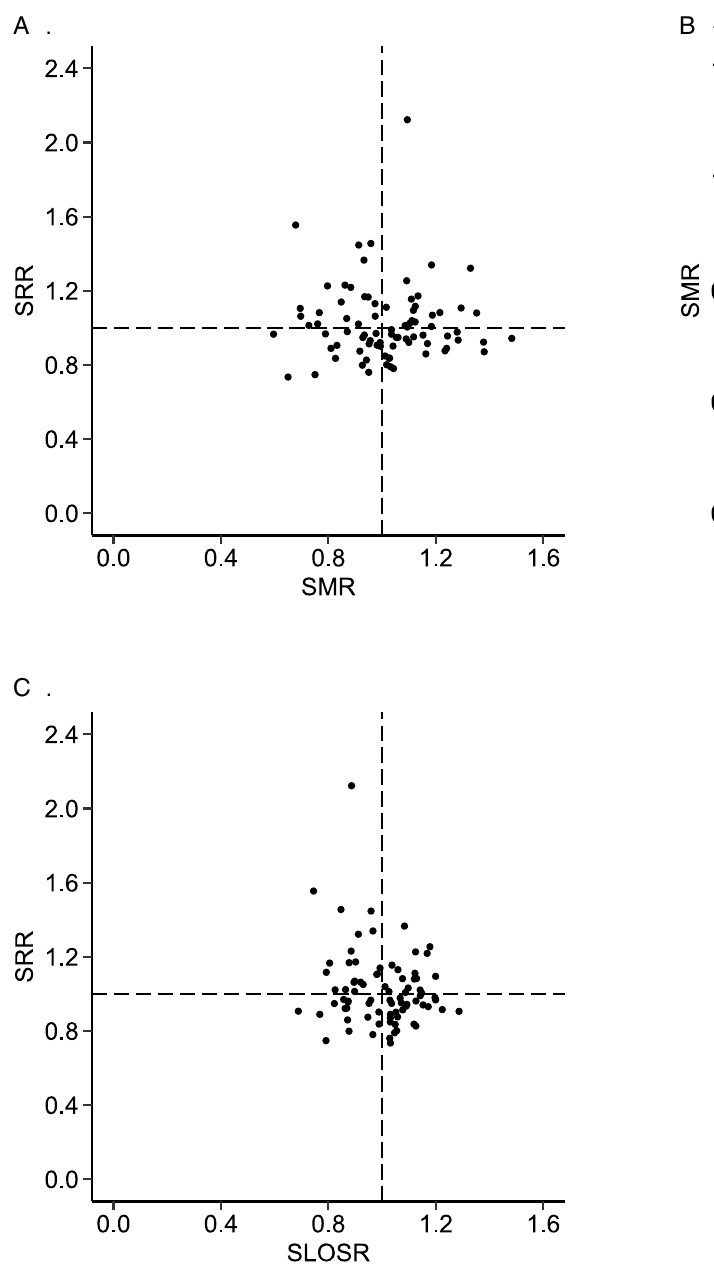
Fig 2. Pairs of quality indicators plotted against each other on ICU level. Fig 2A: standardized in-hospital mortality ratio (SMR) against standardized ICU readmission within 48 hours ratio (SRR). Fig 2B: standardized length of stay ratio (SLOSR) against SMR. Fig 2C: SLOSR against SRR.